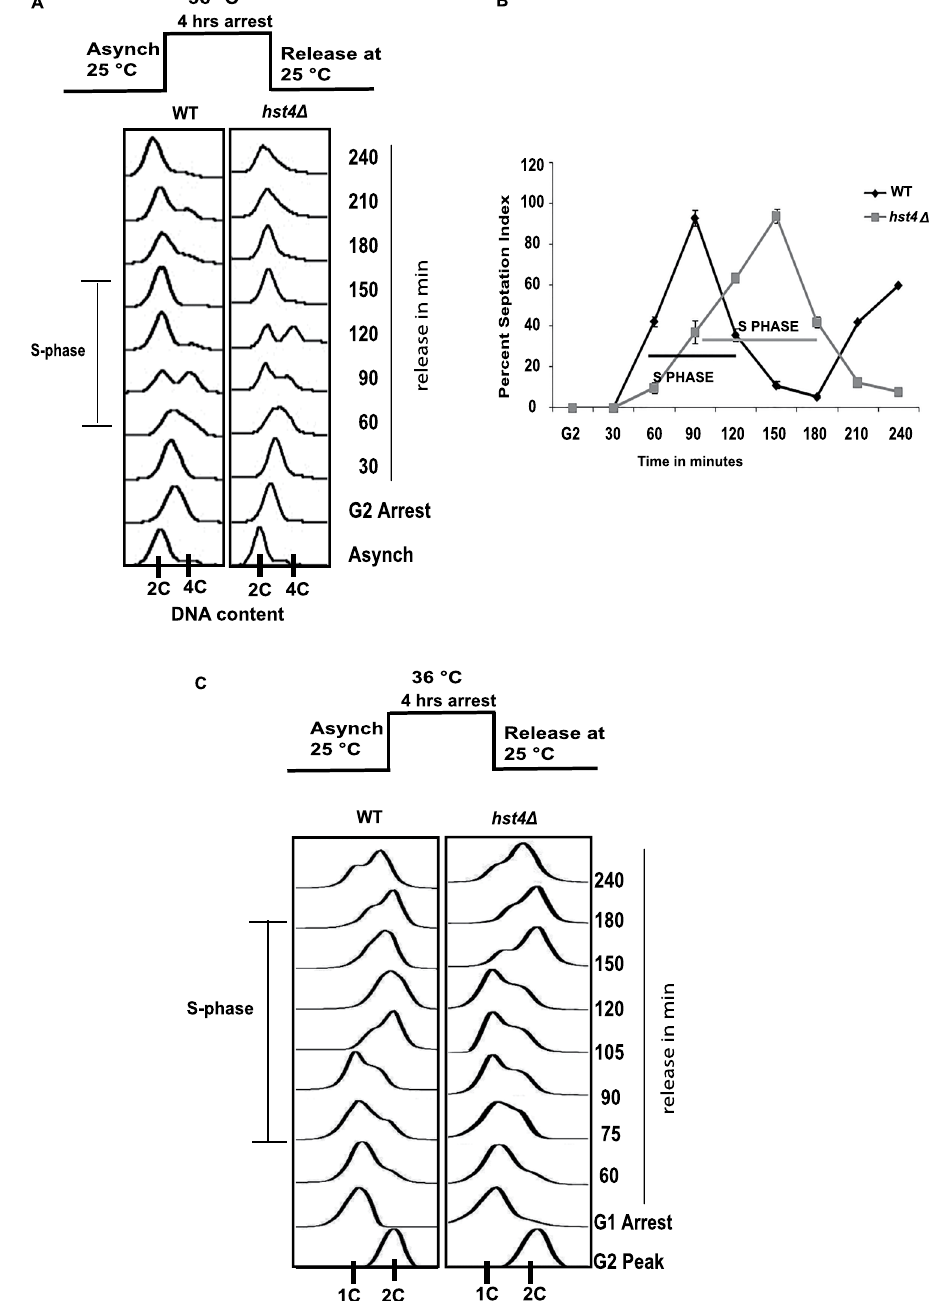
Figure 1. Deletion of hst4 causes S phase delay. ( A ) Flow cytometry profile showing cell cycle progression of wild type (WT) and hst4 Δ mutants synchronized at G2/M phase.The cdc25 - 22 mutant strain (FY4225) and cdc25 - 22 hst4 Δ (DHP56) were grown in YES medium to log phase at permissive temperature (25 °C) and shifted to restrictive temperature (36 °C) for 4 hr, inducing G2/M arrest. Cells were shifted to permissive temperature (25 °C) after 4 hr, cells were collected every 30 minutes and cell cycle profile was analyzed by flow cytometry. ( B ) Septation index for corresponding cell cycle arrest in ( A ) showing percentage of cells with septa at each time point after release from G2 arrest. Calcofluor was used to stain the septa and DAPI was used to localize the nucleus. ( C ) Flow cytometry profile showing cell cycle progression of wild type (WT) and hst4 Δ mutants synchronized at G1/S phase. The cdc10-v50 mutant strain (FY563) and cdc10-v50 hst4 Δ (DHP91) were grown in YES medium to log phase at permissive temperature (25 °C) and shifted to restrictive temperature (36 °C) for 4 hr, inducing G1/S arrest. Cells were shifted to permissive temperature (25 °C) after 4 hr, cells were collected every 30 minutes and cell cycle profile was analyzed by flow